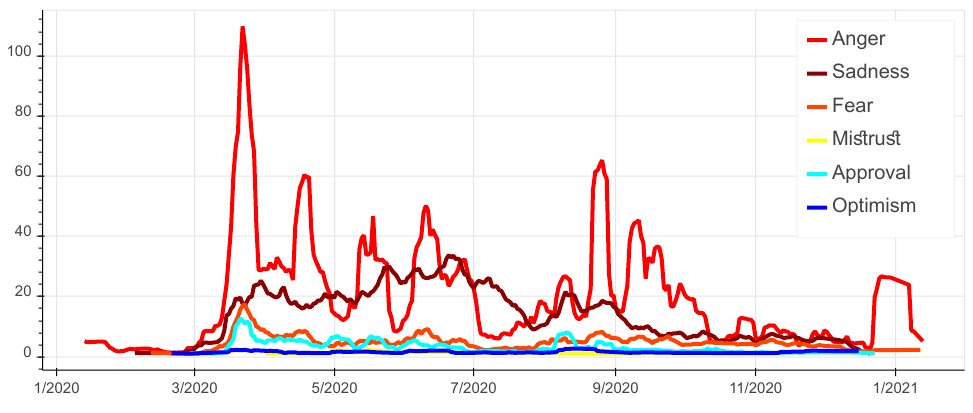
Figure 5. Summary of evolution of emotions in